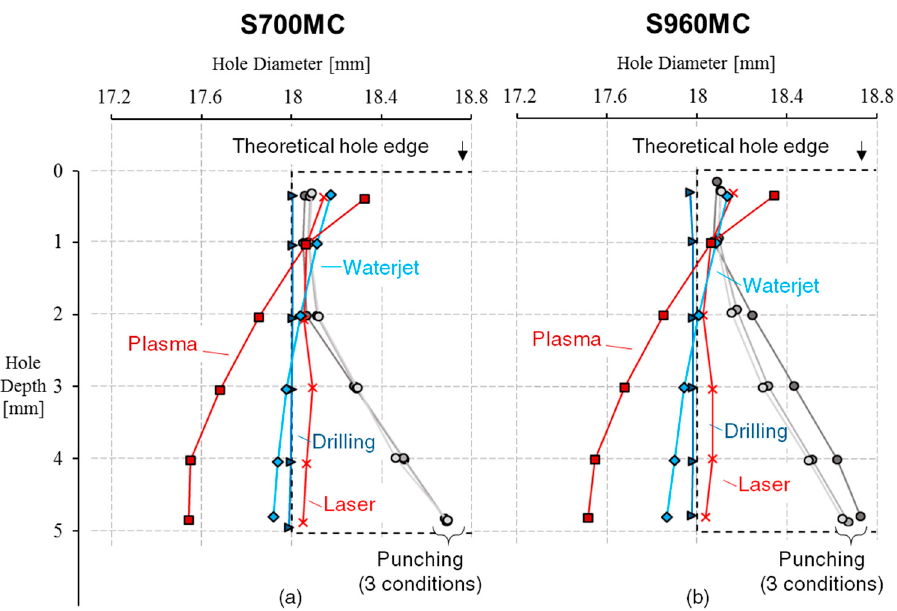
Figure 9. Hole diameter along sample thickness for waterjet cutting, laser cutting, drilling, and punching in ( a ) S700MC and ( b ) S960MC.